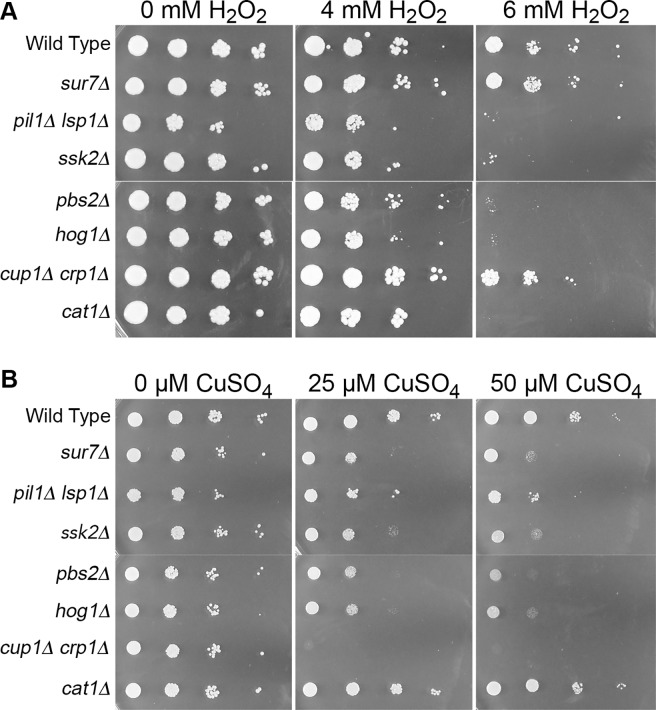
Copper sensitivity does not correlate with sensitivity to oxidative stress.Dilutions of the indicated cells were spotted onto (A) YPD containing H2O2 or (B) synthetic medium with CuSO4. A cat1Δ catalase deletion served as a control as it is highly sensitive to oxidative stress, but grew to wild type levels on CuSO4 media. Conversely, the known copper-sensitive mutant cup1Δ crp1Δ grew well on H2O2, but failed to grow on either CuSO4 concentration. Hog1 pathway strains pbs2Δ, sskΔ 2, and hog1Δ all displayed sensitivity to increasing concentrations of both H2O2 and CuSO4, as did pil1Δ lsp1Δ. sur7Δ was inhibited by copper but grew similar to wild type on H2O2 media. Images are representative of two independent experiments performed on different days. Strains used were wild type, DIC185, sur7Δ (YJA11), pil1Δ lsp1Δ (YHXW21-1), ssk2Δ (YLD185-7), pbs2Δ (YLD197-1), hog1Δ (YLD184-3), cat1Δ (MT505-A), and cup1Δ crp1Δ (KC25).